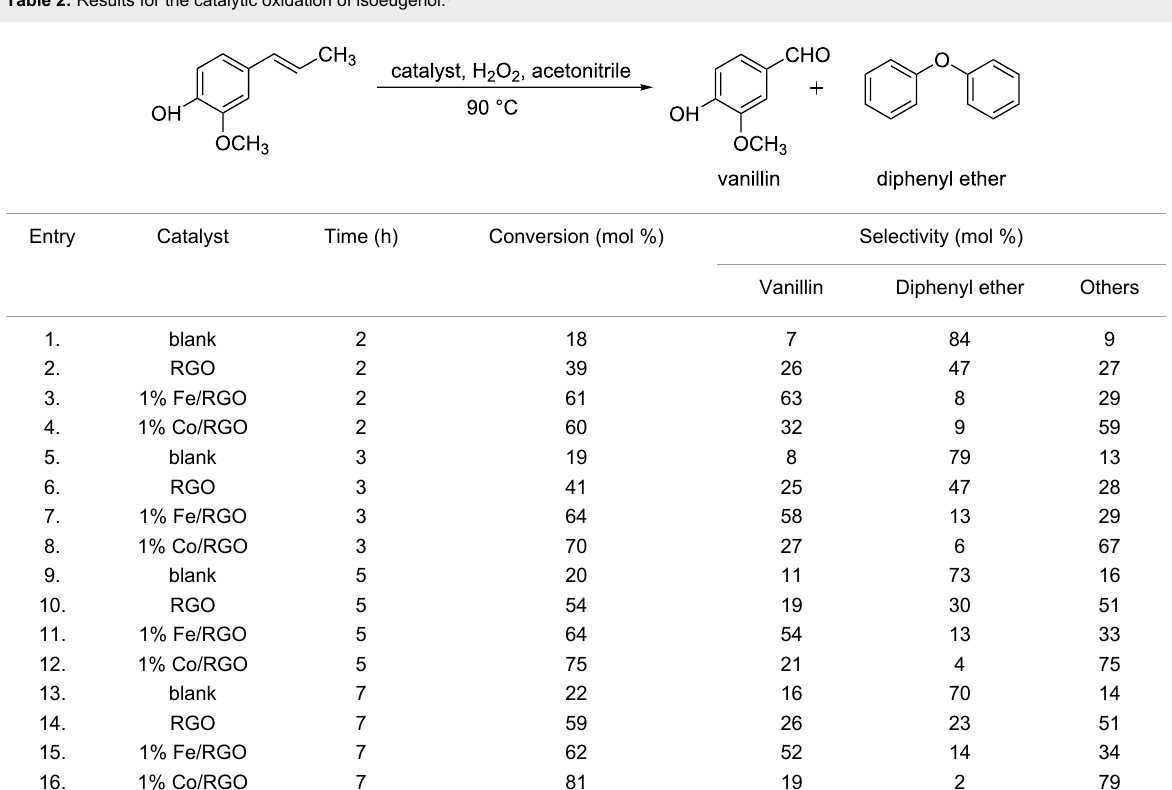
Table 2: Results for the catalytic oxidation of isoeugenol.